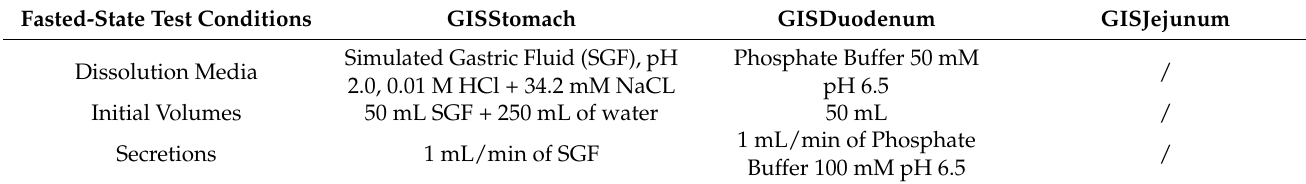
Figure 1. Setup and design of the GIS that was applied to test the products in fasted-state conditions. A tablet of each product was added to the stomach compartment at the start of the study. The dissolution media, initial volumes, and secretion rates are described in Table 3. Table 3. Experimental conditions in the GIS for testing the different drug products of the drug.